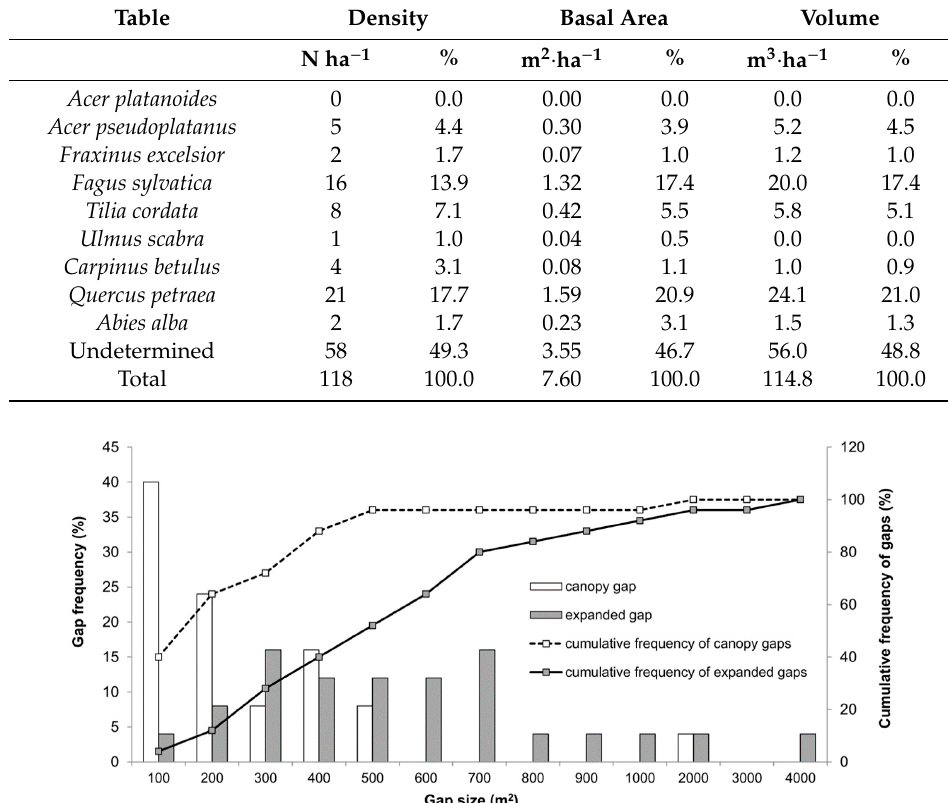
Table A1. Species composition and basic characteristics of deadwood on the permanent research plot.